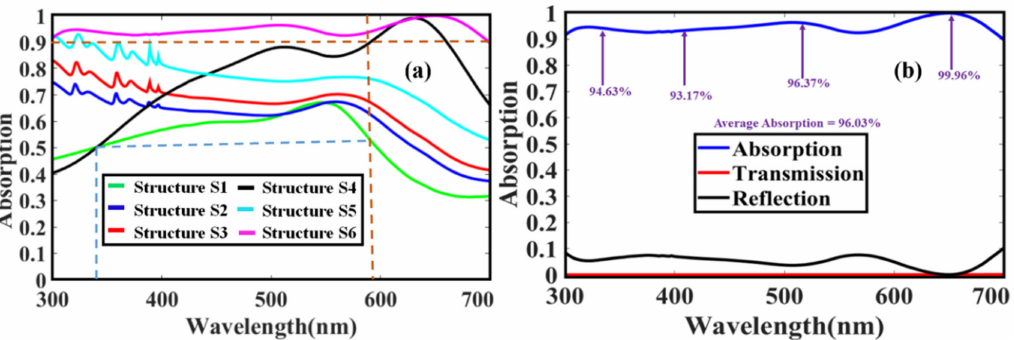
Figure 3. ( a ) Comparison of absorption spectra of S1, S2, S3, S4, S5, and S6 structures and ( b ) reflection, transmission, and absorption spectra of S6 solar